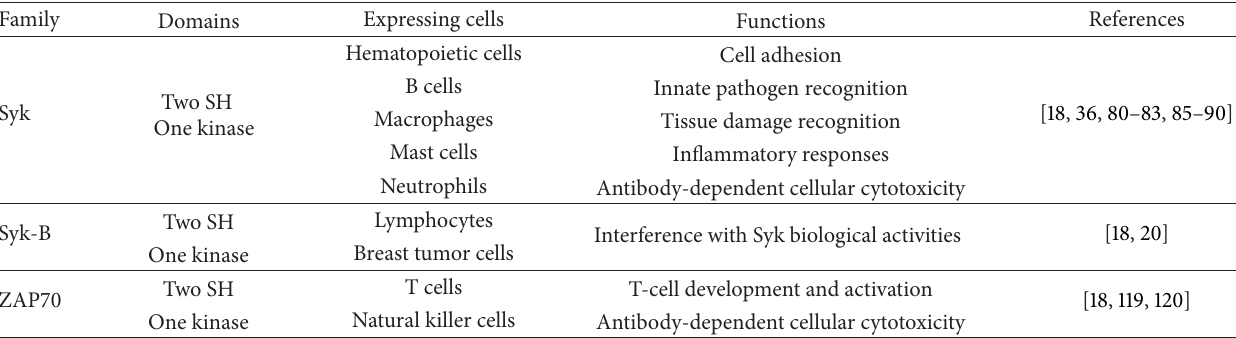
Table 1: Syk family kinases and their